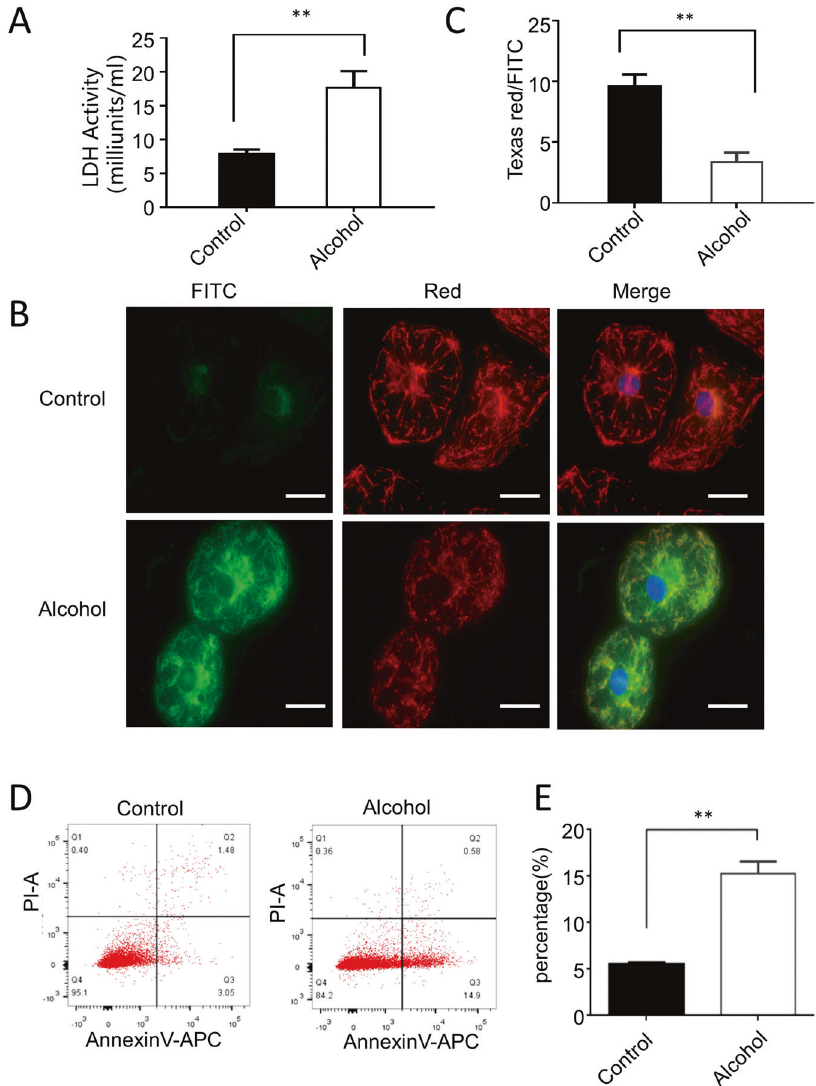
Fig. 2 Alcohol-induced cardiomyocyte damage. A LDH activity assay showed that 100 mM alcohol can induce the upregulation of LDH expression in hiPSC-CMs 2.5 times ( n = 7). B HTS analysis showed that the red-green fl uorescence ratio has signi fi cantly dropped ( n = 7). C The representative immuno fl uorescence image of JC-1 labeling showed that the green fl uorescence expression of hiPSC-CMs signi fi cantly increased after treatment with 100-mM alcohol for 2 h. Scale bar = 25 μ m. D , E Flow cytometry and quantitative analysis showed that 100-mM alcohol increased early apoptosis of hiPSC-CMs ( n = 3). Results are presented as means ± standard error of the mean (** P < 0.01; two-sided Student ’ s t -test or one-way analysis of